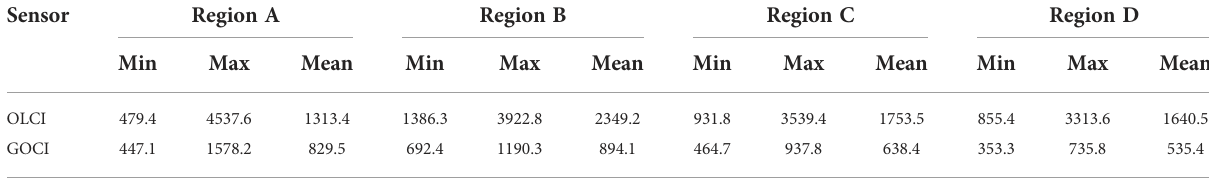
TABLE 5 Statistics of SSC in the experimental regions based on 2020 data (unit: mg/L).